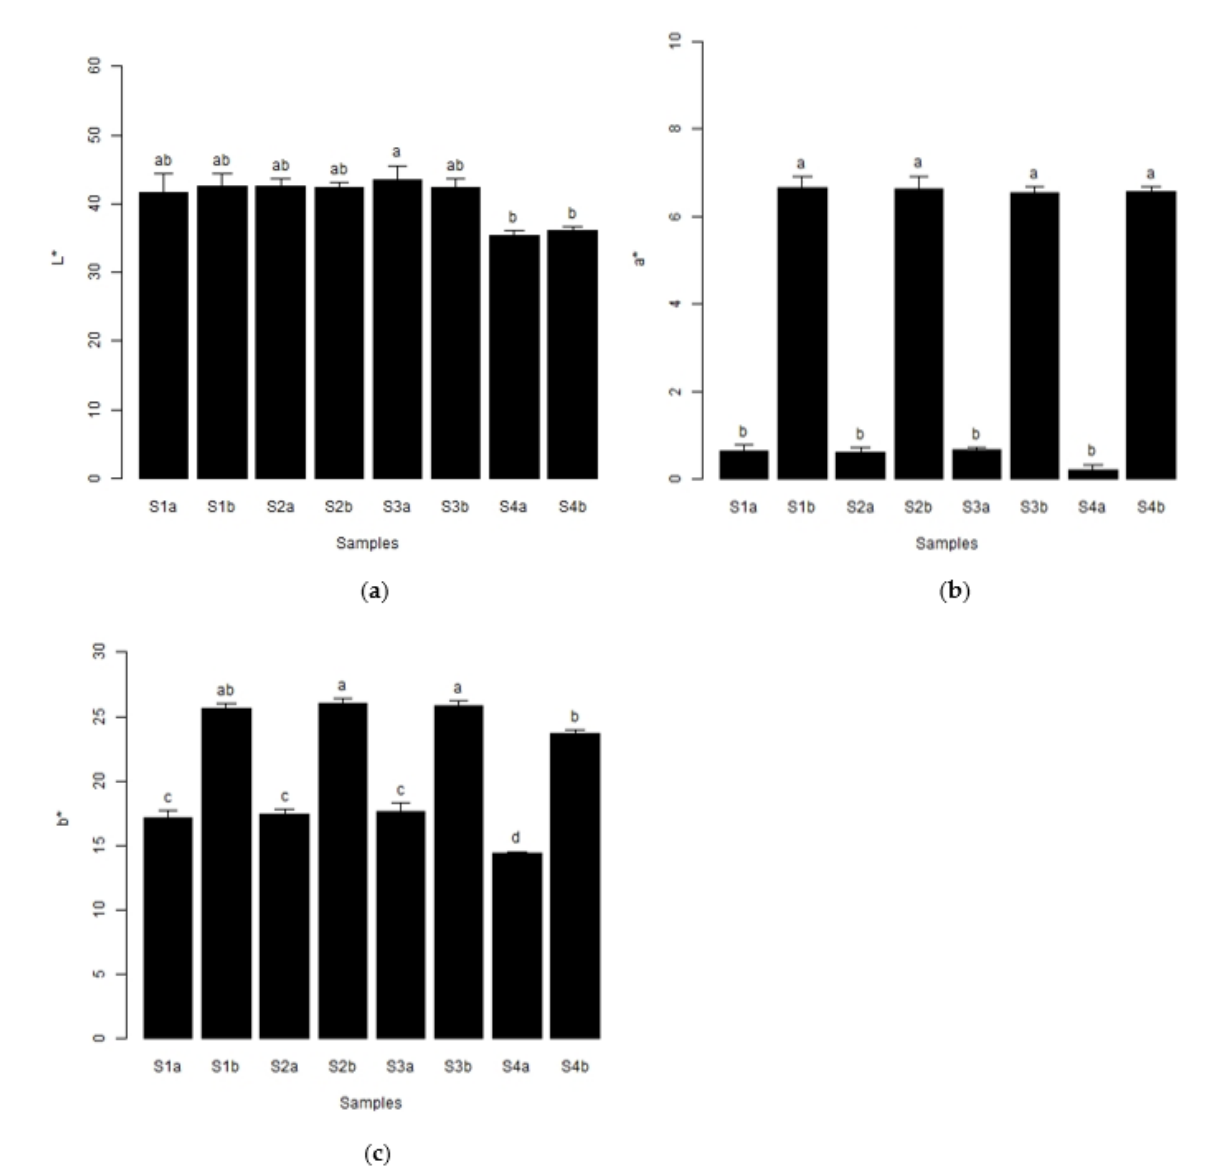
Figure 1. Colorimeter CIELab System with the color parameters ( n = 9): ( a ) L* (lightness); ( b ) a* (red–green transitions); and ( c ) b* (yellow–blue transitions) of soil samples before (S1a, S2a, S3a, and S4a) and after (S1b, S2b, S3b, and S4b) performing organic matter content. Letters a, b, c, d indicate sig-